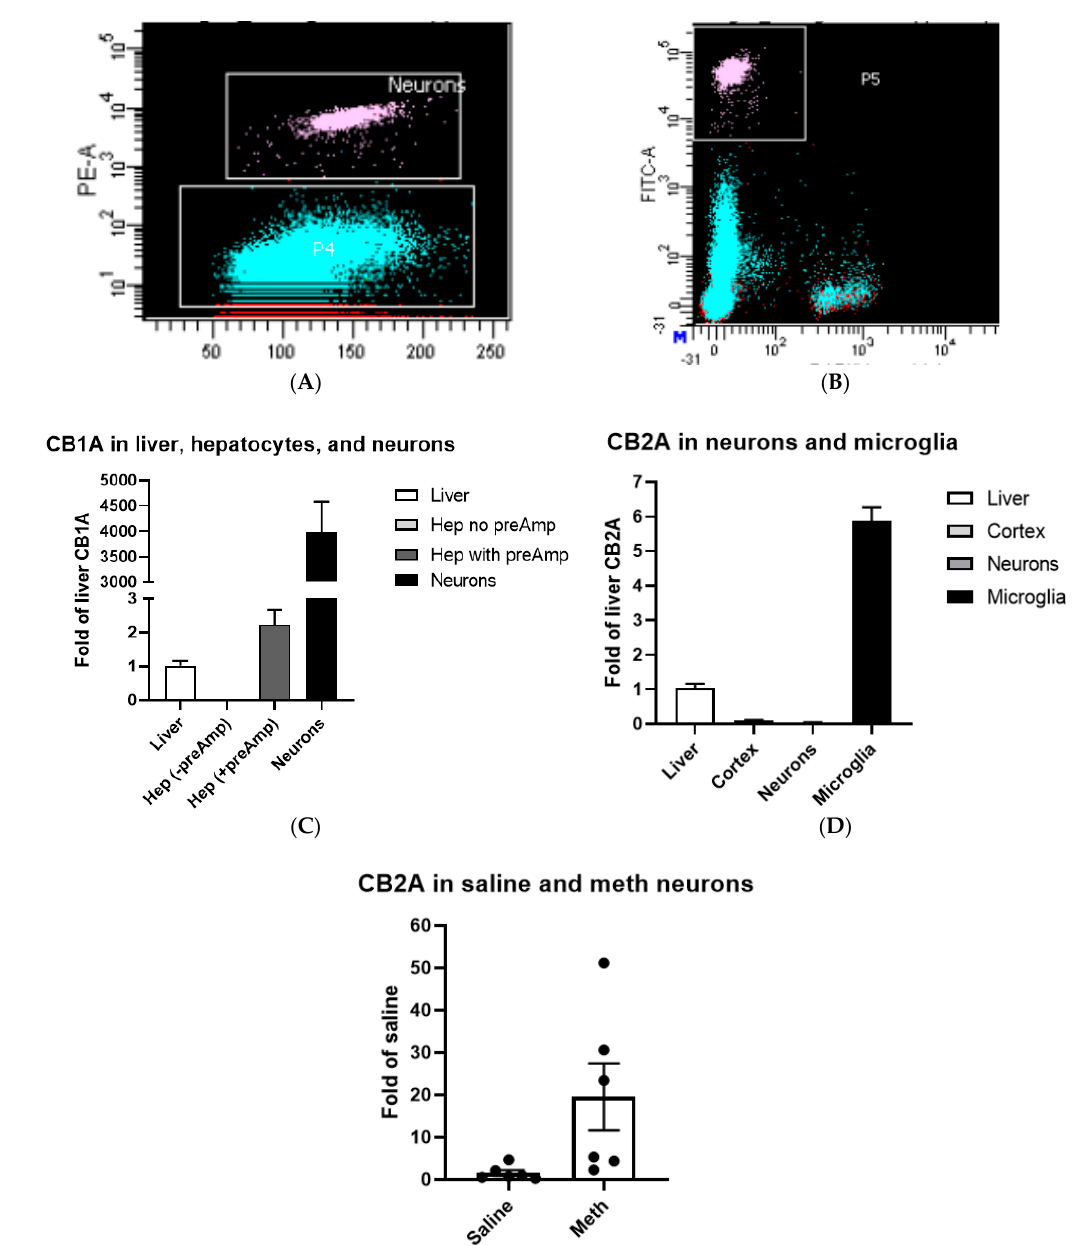
Figure 2. Fluorescence-activated cell sorting (FACS) of neurons and microglia. ( A ) The Y-axis is the fluorescent intensity of rat cortex neurons labeled with R-phycoerythrin (PE) conjugated NeuN antibody in logarithmic plots, and X-axis is the forward-scatter in linear scale representing cell sizes. ( B ) The Y-axis is the fluorescence intensity of transgenic Cx3c1-eGFP mouse cortex microglia in logarithmic plots, and the X-axis is the forward-scatter logarithmic plots representing cell sizes. ( C ) Comparison of low baseline CB1R expression in liver ( n = 4), hepatocytes ( n = 4, RT-preAmp-qPCR), and neurons ( n = 6) using liver CB1A as a reference. ( D ) Comparison of low baseline CB2R expression in mouse cortex ( n = 6), neurons ( n = 6) and microglia ( n = 4) using liver ( n = 4) CB2A as a reference. ( E ) Comparison of CB2A expression in rat cortex neurons of saline ( n = 6) and methamphetamine ( n = 6) treatments.